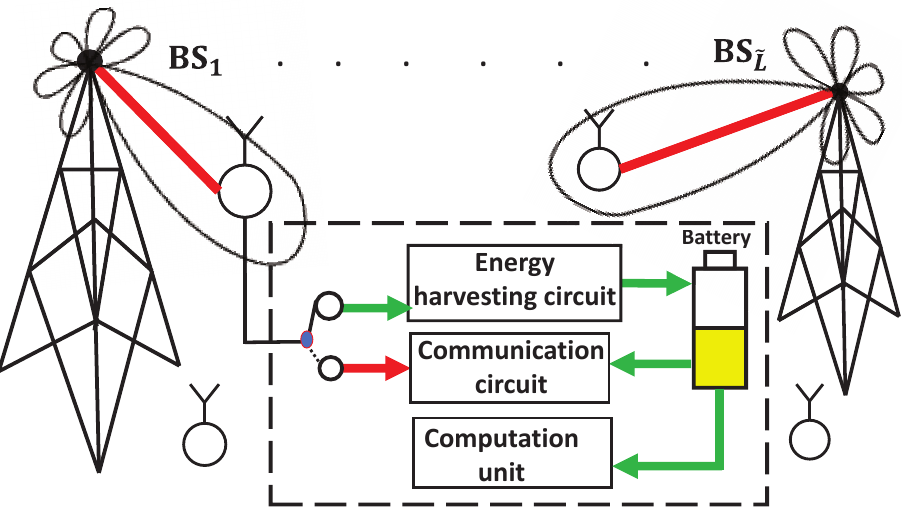
Figure 1. A system model with respect to the joint beamforming, power allocation, and splitting con- trol for SWIPT-enabled IoT networks. In this model, each mobile node has a power split mechanism to split the received signal into two streams, one sent to the energy harvesting circuit for harvesting energy and the other to the communication circuit for decoding